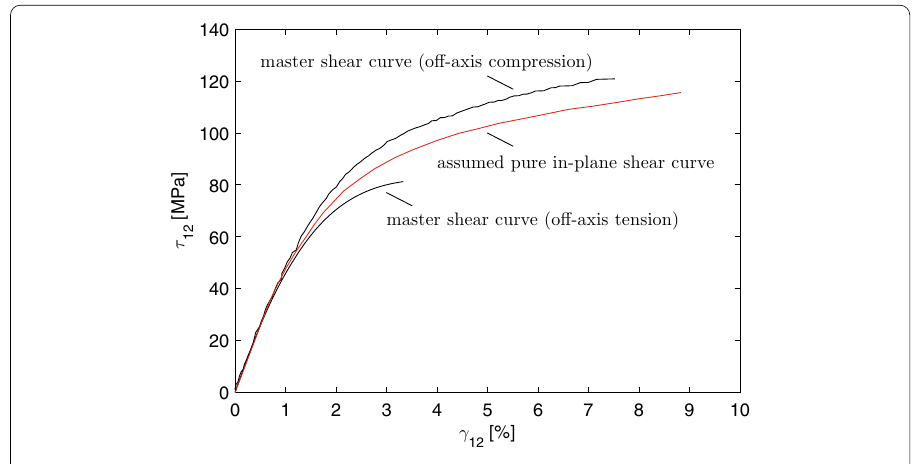
Fig. 7 Quasi-static in-plane shear behavior, deduced from off-axis tensile and off-axis compression tests (engineering stress–strain curves